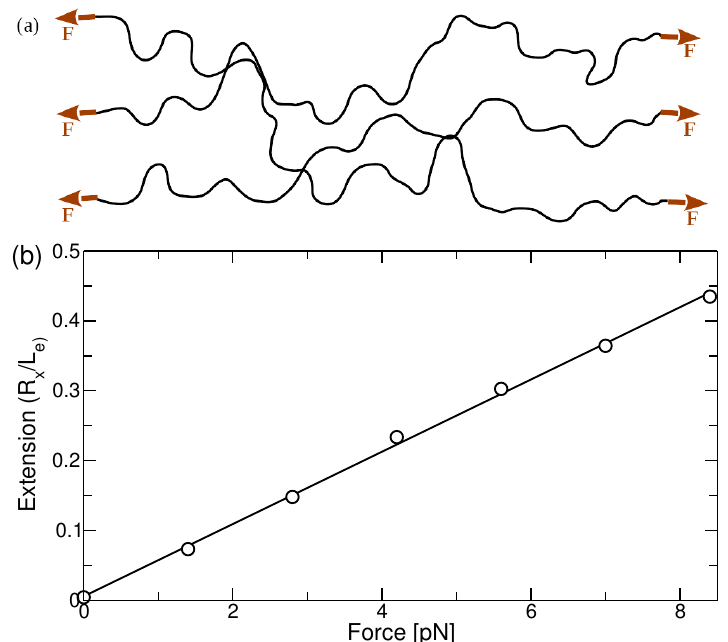
Figure 2. ( a ) Schematic for the application of force dipole. ( b ) Extension ratio of the polymer chains along the direction of the force in the reference state. In this work, only weak forces in the linear stretching regime are